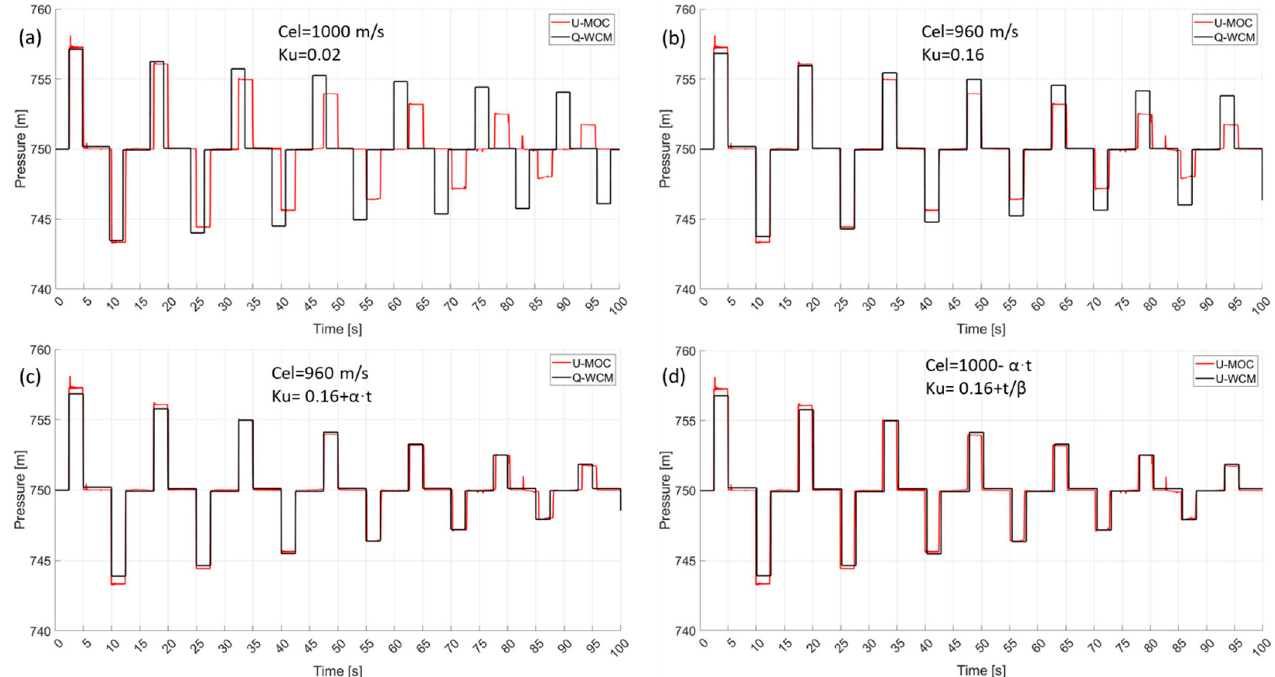
Figure 2. Comparison between the WCM and the U-MOC models at node 2, for the first case study.